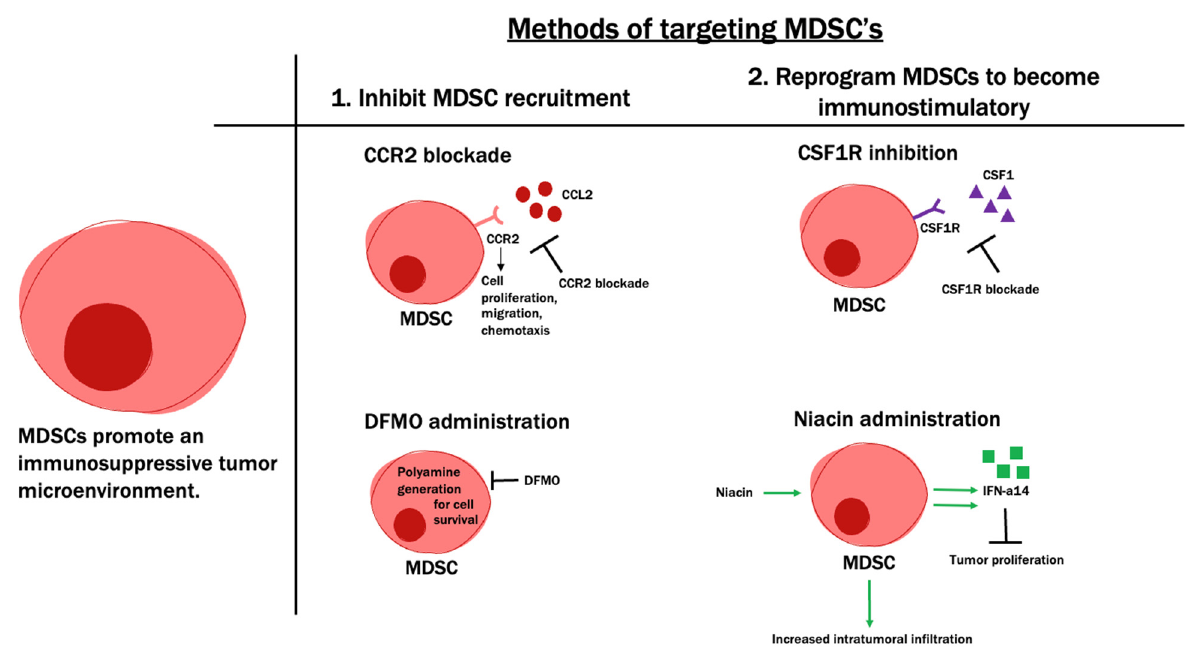
Figure 5. MDSCs can be targeted through various mechanisms. MDSCs (myeloid-derived suppressor cells) promote an immunosuppressive tumor microenvironment. Two main methods of targeting MDSCs include (1) inhibiting MDSC recruitment, such as with CCR2 (C-C chemokine receptor 2) blockade, as well as DFMO (difluormethylornithine) administration, and (2) reprogramming MDSCs to become immunostimulatory, such as with CSF1R (colony-stimulating factor 1 receptor) inhibition and niacin administration.